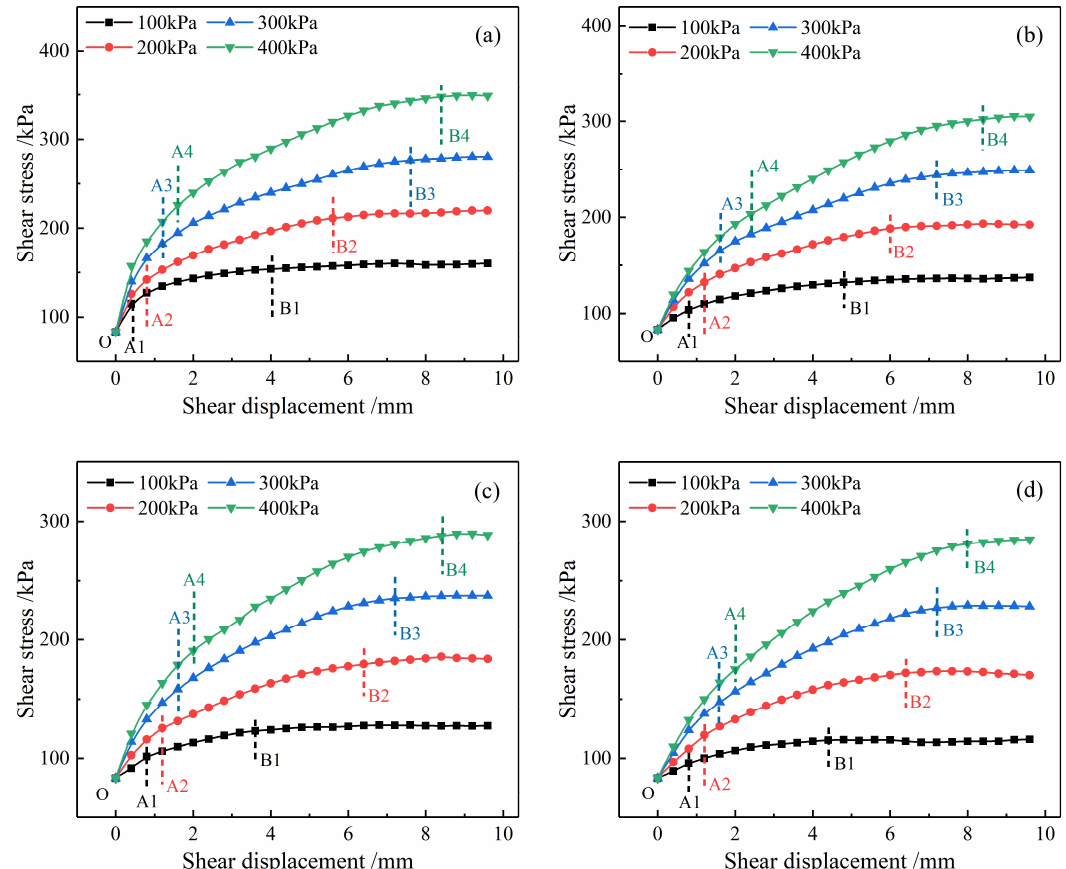
Figure 6. τ - δ curve of partial CPB: ( a ) N-L; ( b ) 2-L-10; ( c ) 2-L-15; ( d ) Figure 6.  -  curve of partial CPB: ( a ) N-L; ( b ) 2-L-10; ( c ) 2-L-15; ( d ) 2-L-20. The representative N-L, 2-L-10, 2-L-15 and 2-L-20 CPB were selected to analyze the